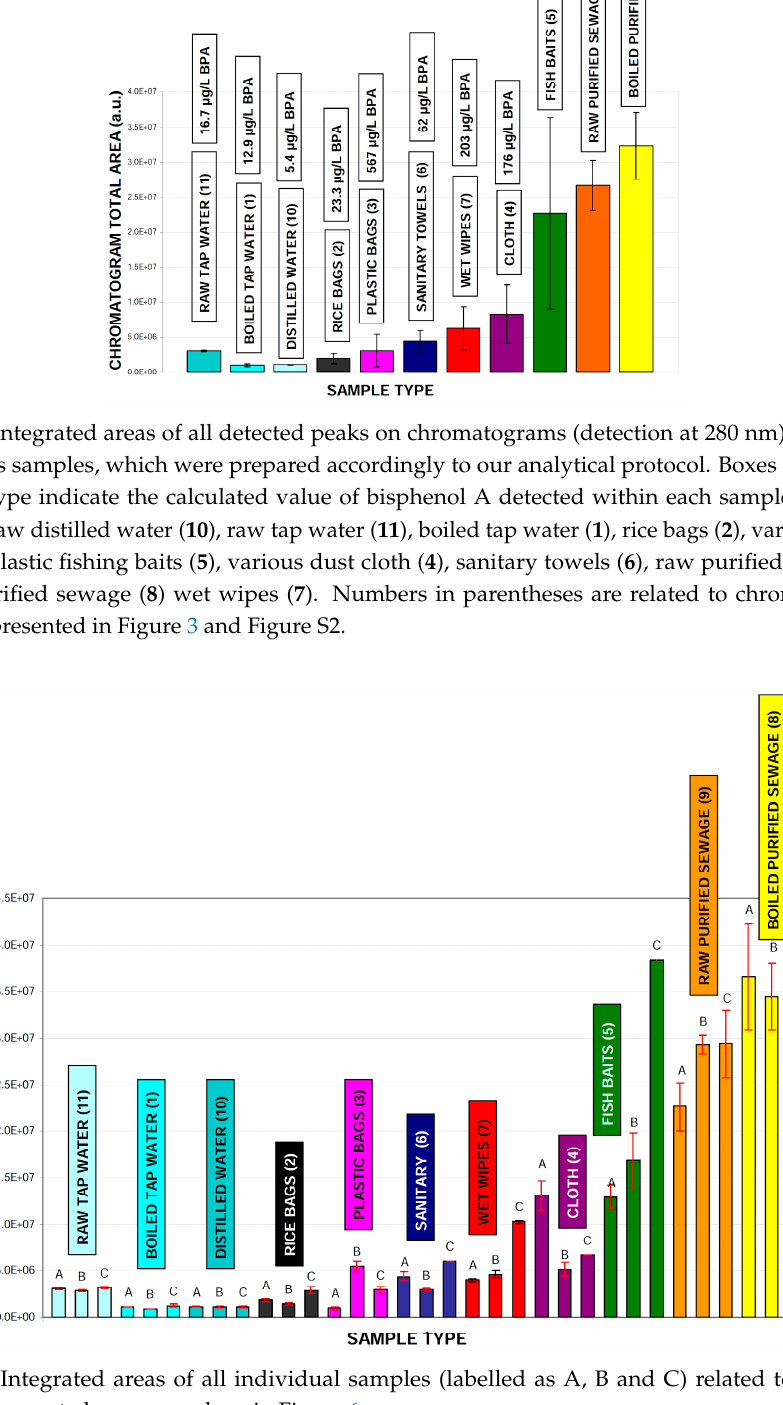
Figure 6. Correlation observed between SPE extracts contents (the total peaks area on UV-DAD chromatograms) and the bisphenol A peak area for each extracted material. Sample labelling: A . all